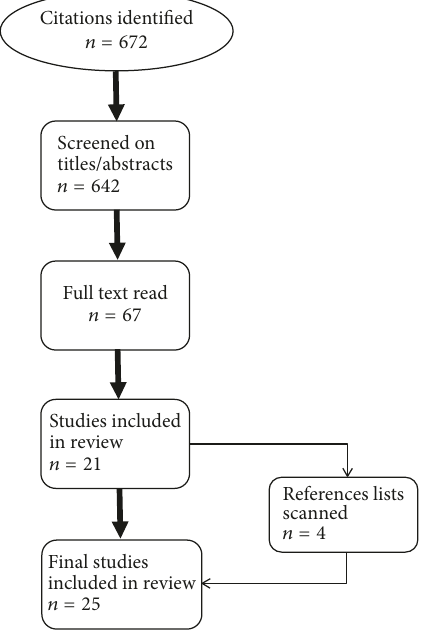
Figure 1: Chart of the literature